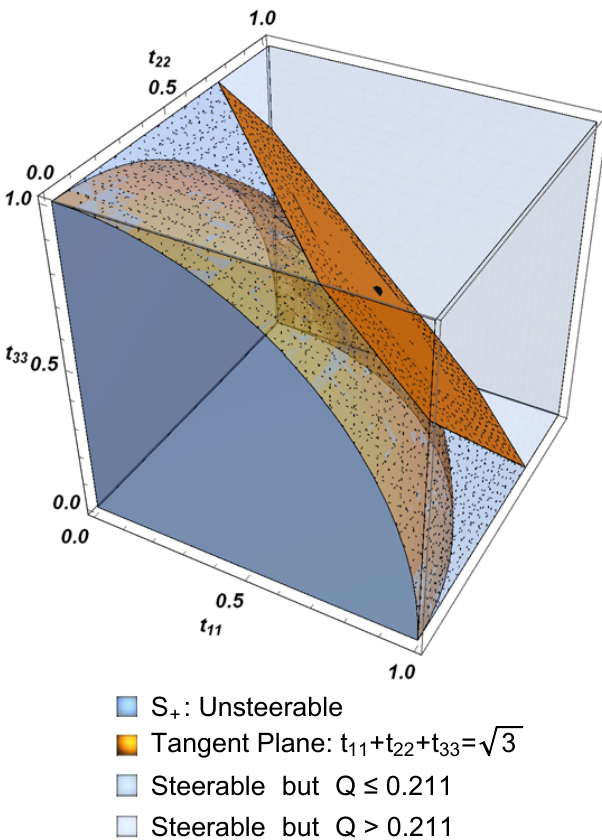
Figure 1: Singular value space of correlation tensor of an arbitrary two-qubit state considered here. Cuboid indicates all possible two-qubit states whereas any point from the first octant S + of sphere S (18) gives F 3 unsteerable state. The region lying outside S + and below the tangent plane at P ( 1 √ indicates steerable but useless states whereas that lying above the tangent plane gives useful states.